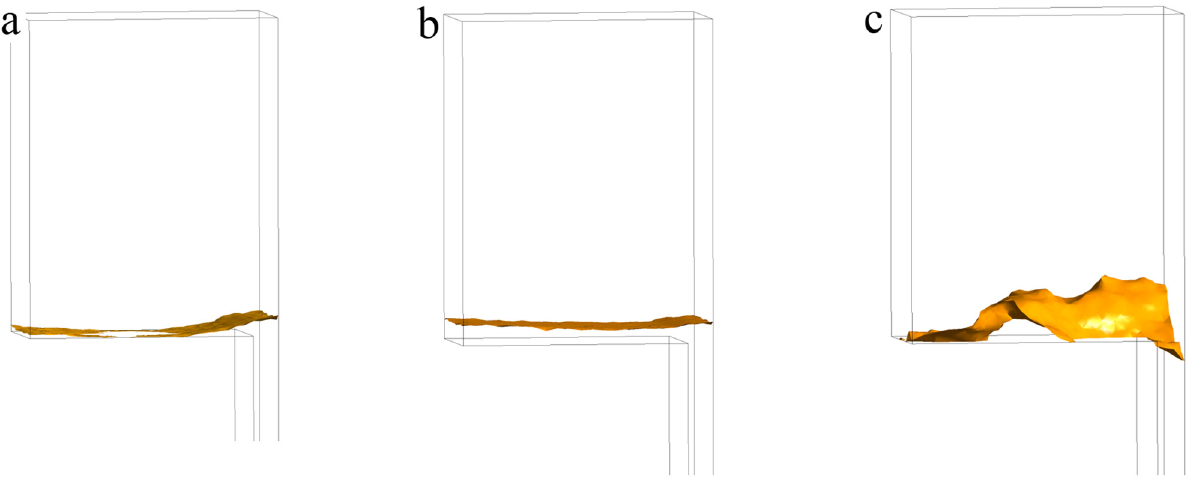
Figure 8. The solidification interface morphology: ( a ) No TMF; ( b ) I = 8 A, f = 50 Hz; ( c ) I = 25 A, f = 50 Hz.